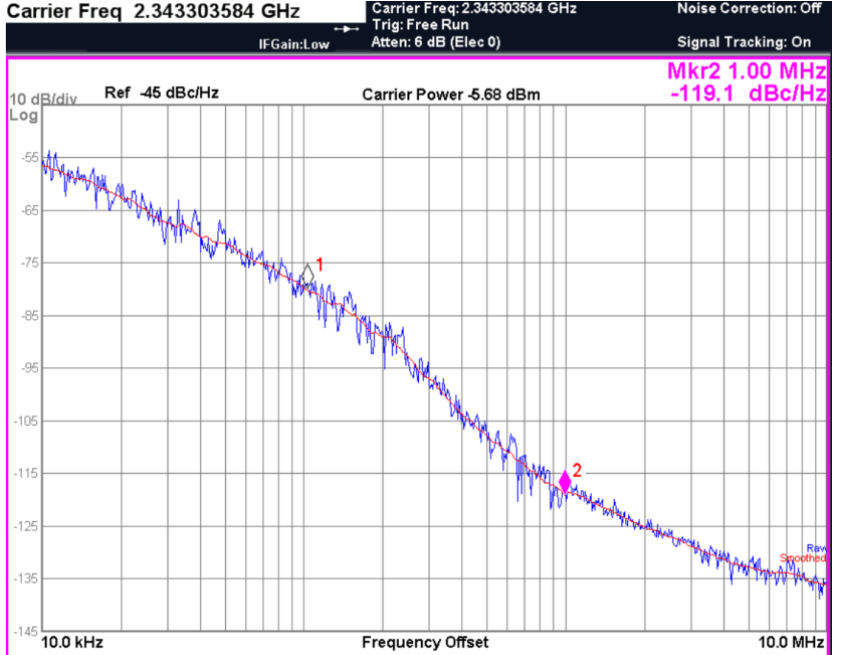
Figure 18. Measured phase noise performance of free-running